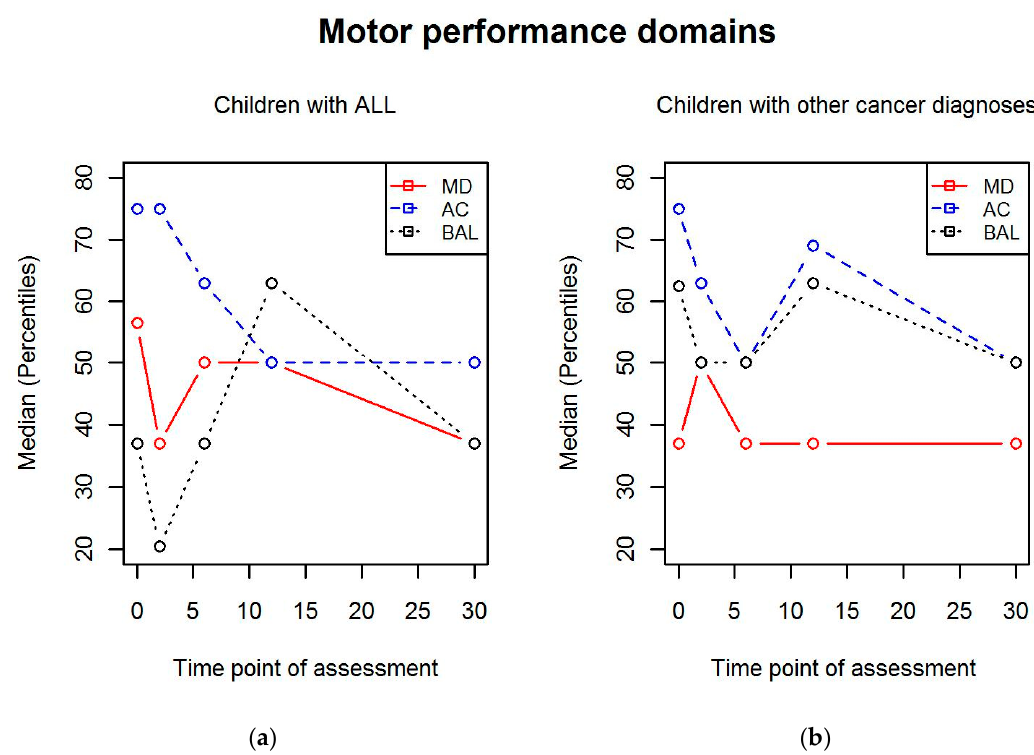
Figure 3. The changes in the different domains of motor performance during treatment in ( a ) children with acute lymphoblastic leukemia (ALL) and ( b ) children with other cancer diagnoses. MD = manual dexterity; AC = aiming and catching; BAL = balance.